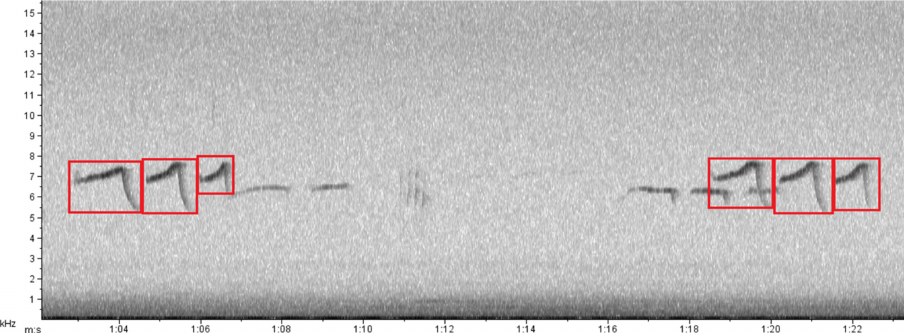
Figure 2. Spectrogram generated in Raven Pro 1.6 software with phee -type vocalizations (in red squares) of the species Callithrix penicillata , recorded in the morning at the Peti reserve, Minas Gerais,